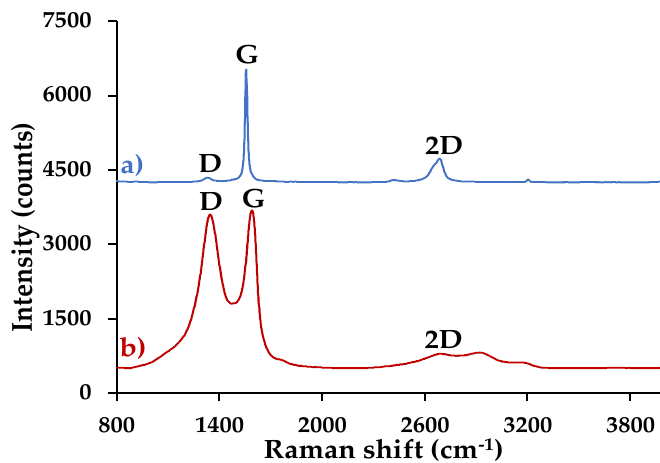
Figure 6. Raman spectrum of ( a ) graphite and ( b ) GO.